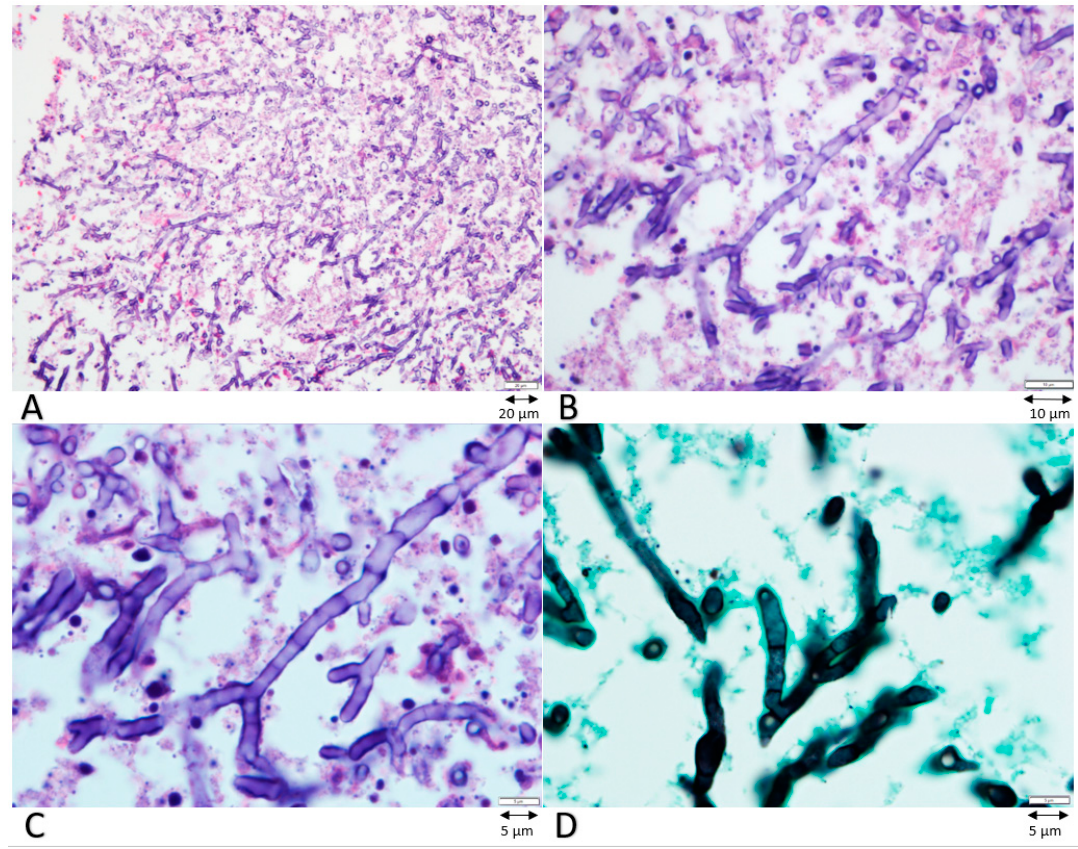
Figure 2. Biopsy images with hematoxylin and eosin stain at different resolutions ( A , B , C ) and silver stain ( D ). Images show septate hyaline hyphae with narrow angle branching compatible with aspergillosis.